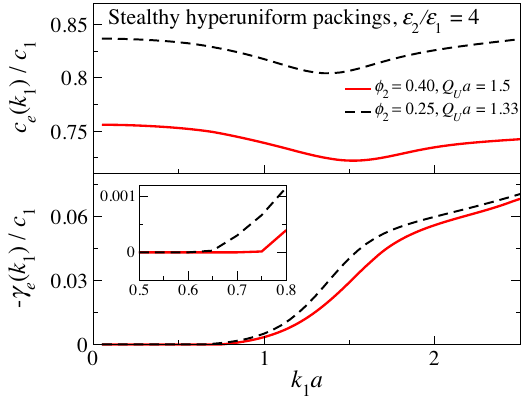
FIG. 12. Predictions of the scaled strong-contrast approxima- tion (73) for the effective wave speed c and the negative of the e as a function of the dimensionless wave attenuation coefficient γ e number k 1 a for 3D stealthy hyperuniform sphere packings of contrast ratio ε 2 = ε 1 ¼ 4 at two different packing fractions: ϕ 0 . 4 with Q a ¼ 1 . 5 and ϕ 2 ¼ 0 . 25 with Q a ≈ 1 . 33 . The 2 ¼ U U inset is a magnification of the lower